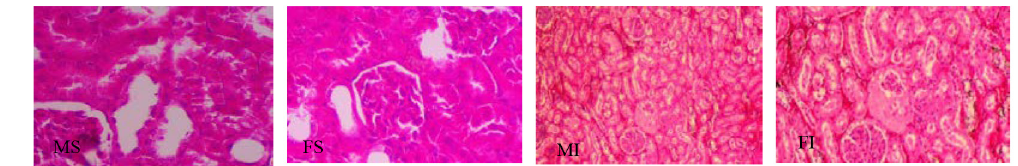
Figure 4. Comparison of Kidney Tissue in Male Sham (MS), Female Sham (FS) with Female Ischemia (FI) and Male Ischemia (MI) Groups. Tissue injury is seen in the ischemia groups.